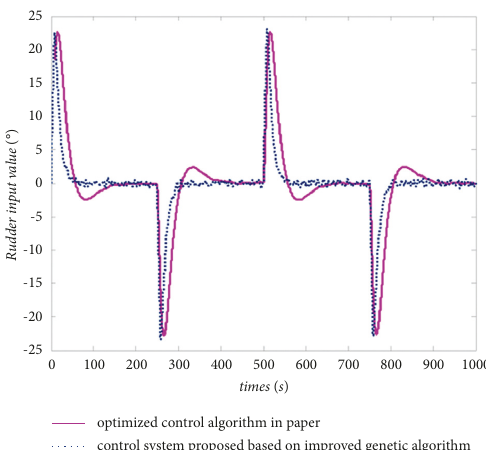
Figure 9: The results of rudder input in the comparison